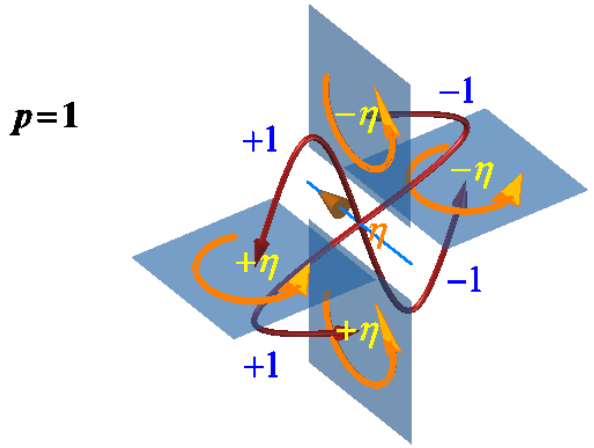
Figure 2: The coboundary